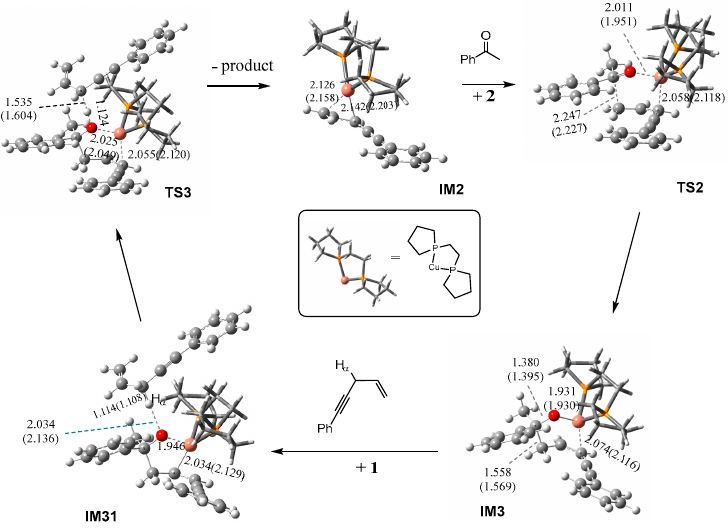
Figure 3. Optimized structures along the catalytic cycle at the M06/6-31G(d,p) level and the B3LYP/6- 31G(d,p) in parentheses. Bond lengths are in angstroms and the angles are in degrees. For TS2 , the closest C–C distance between carbonyl and ene moieties shortens to 2.247 Å. This suggests that the formation of the C–C bond occurs with the ketone addition to the double bond of 1-phenyl-4-penten-1-yne. In IM3 , the C(carbonyl)–C(eneye) bond of 1.558 Å indicates that acetophenone addition to the 1-phenyl-enyne was completed. SMD calculations indicate the above step benefits from 47.4 kJ mol − 1 in Gibbs free energies with a smaller energy barrier of 60.0 kJ mol − 1 , meaning that this ketone addition process occurs easily.